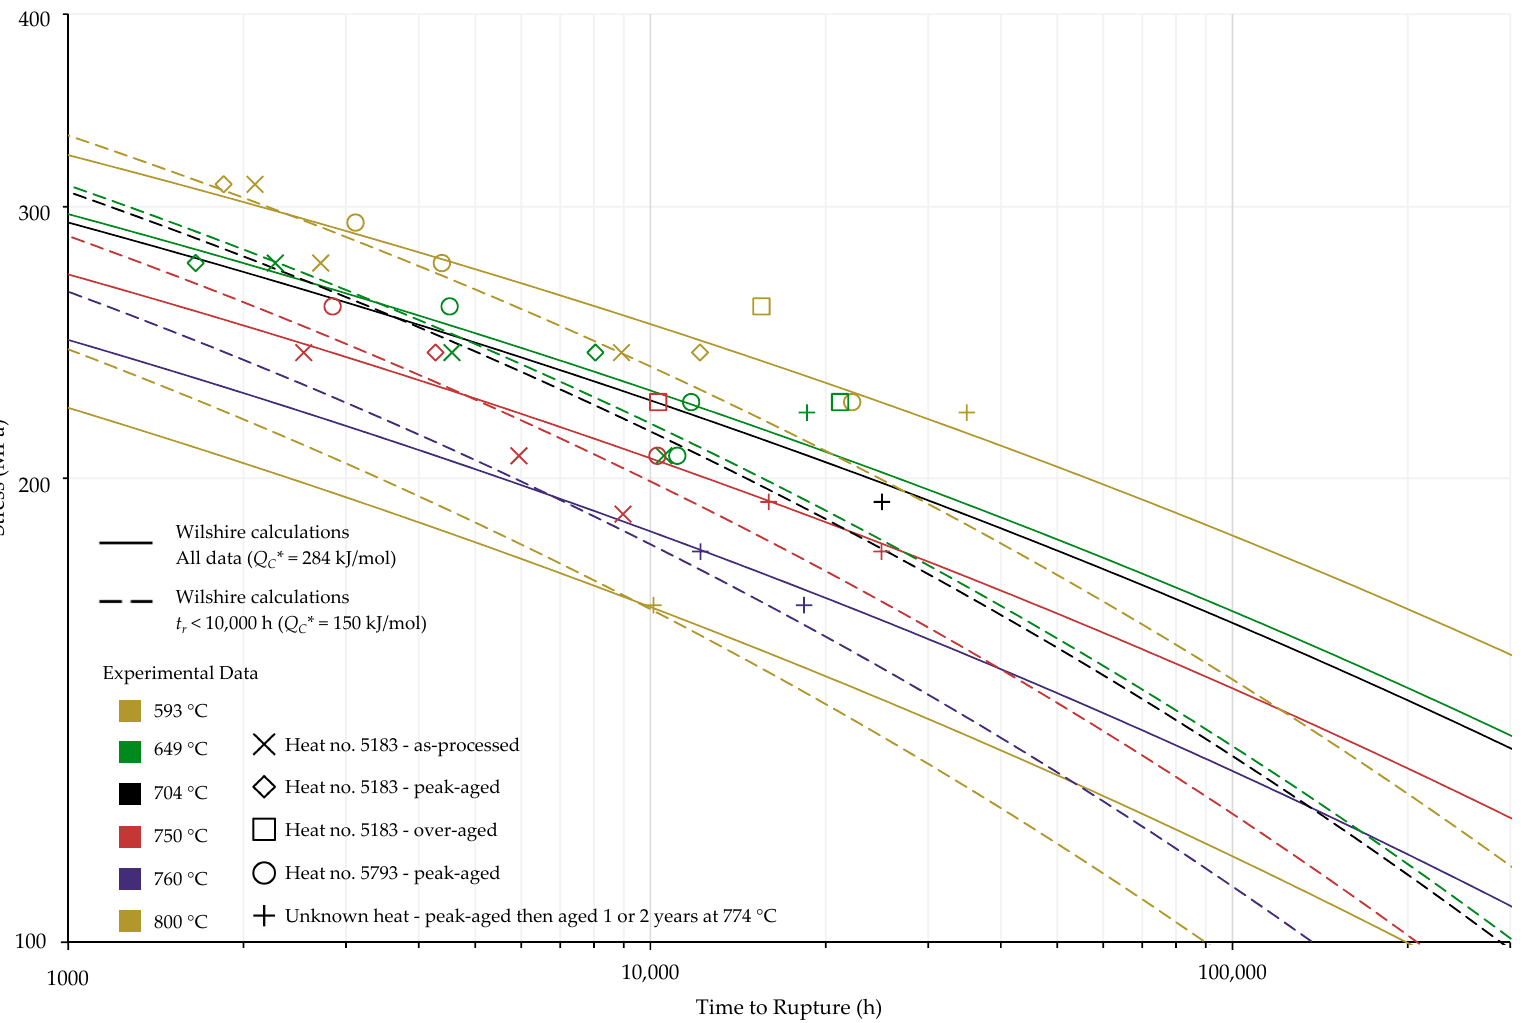
Figure A14. Calculations of the Wilshire equation for Nimonic 105 using average tensile strength values with (cid:1843) (cid:3004)∗ determined using Arrhenius plots.